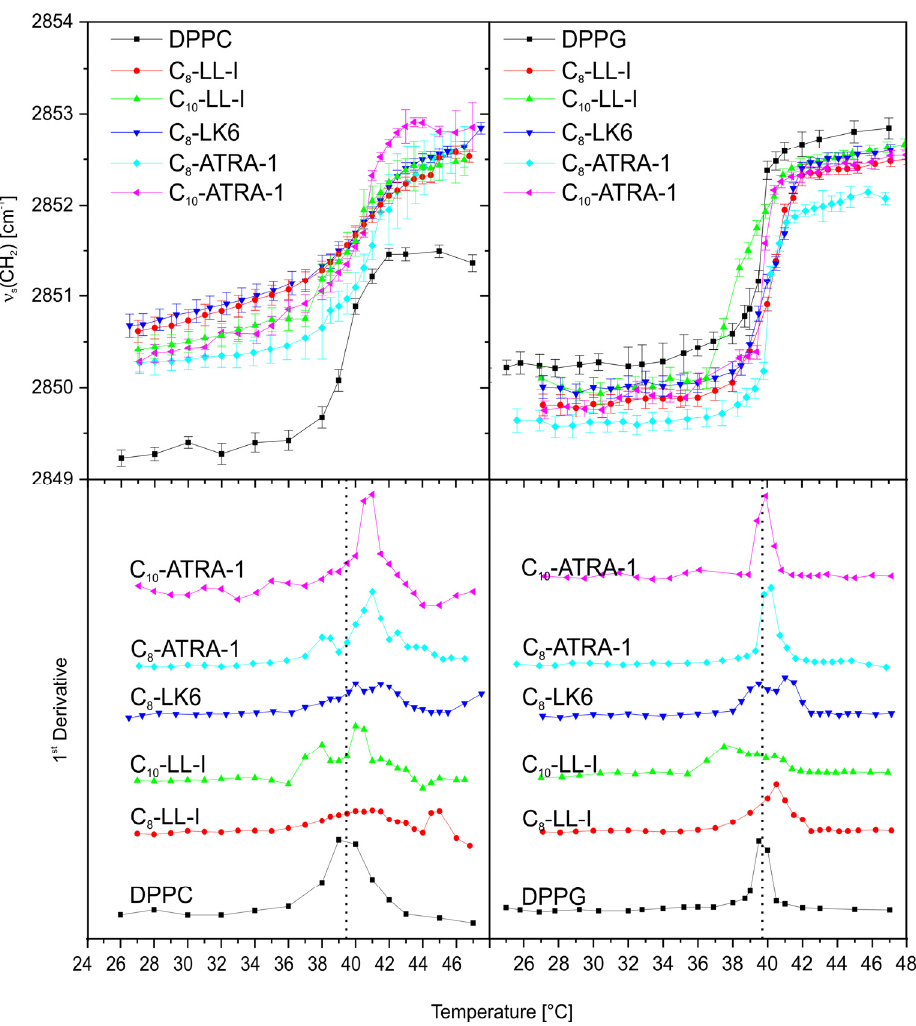
Figure 3. Evaluation of the maximum frequency of the v s (CH 2 ) bands as a function of temperature (top panel) and 1st derivatives (bottom panel) of the relationships for DPPC, and DPPG in the ( top panel) and 1st derivatives ( bottom panel) of the relationships for DPPC, and DPPG in the absence absence and the presence of lipopeptides. and the presence of